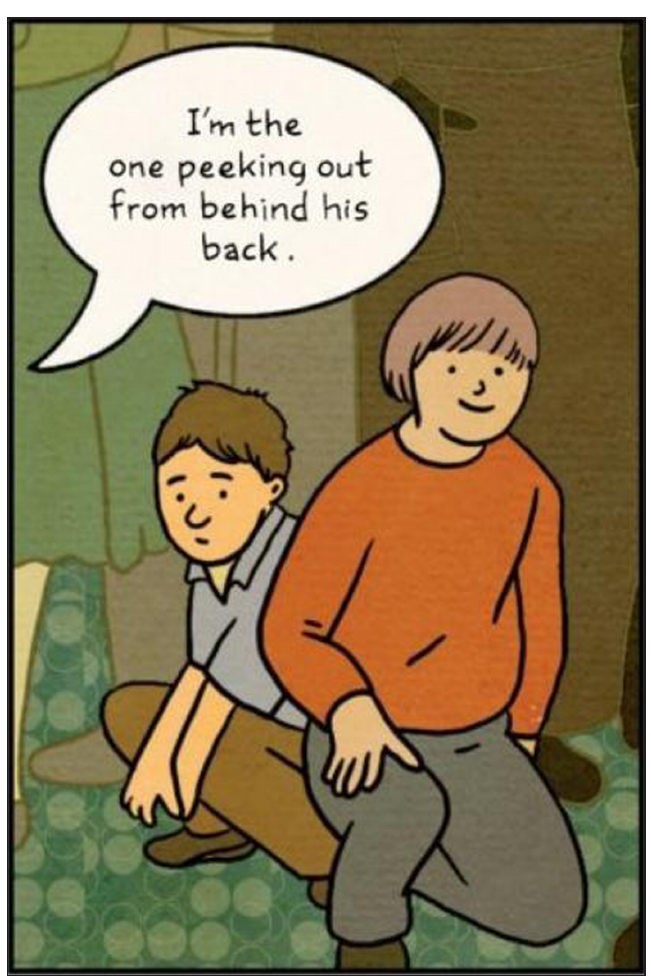
Figure 3: Koby Peering Out from the Shadow of Death in Exit Wounds by Rutu Modan, 2007: 66. © 2007 Drawn & Quarterly – Rutu